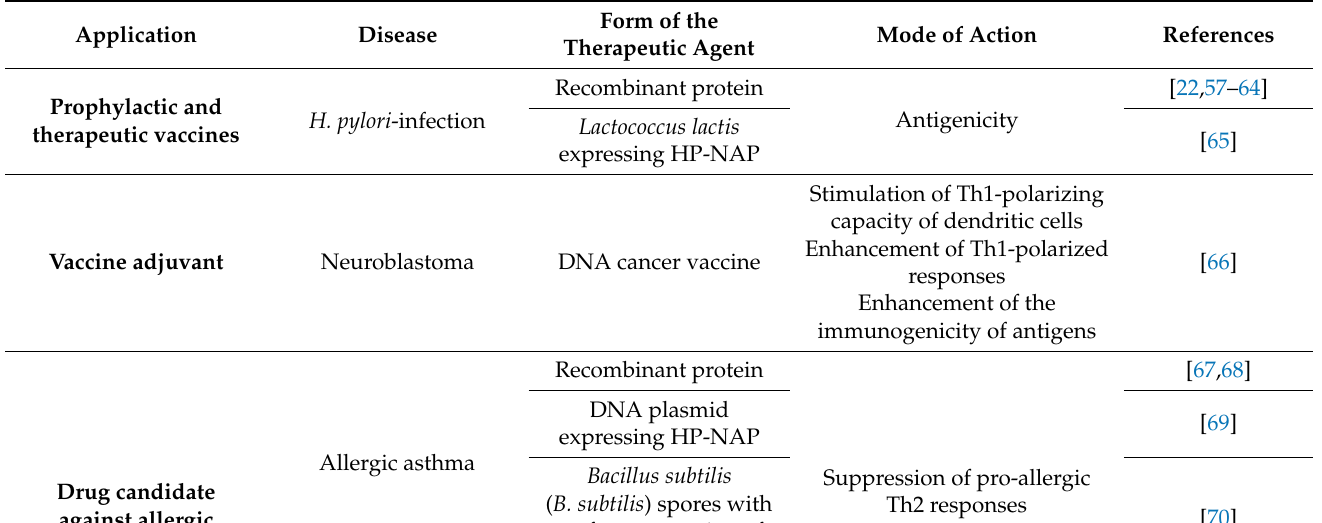
Table 1. Potential applications of HP-NAP as therapeutic agent in vaccine development, allergy treatment, and cancer